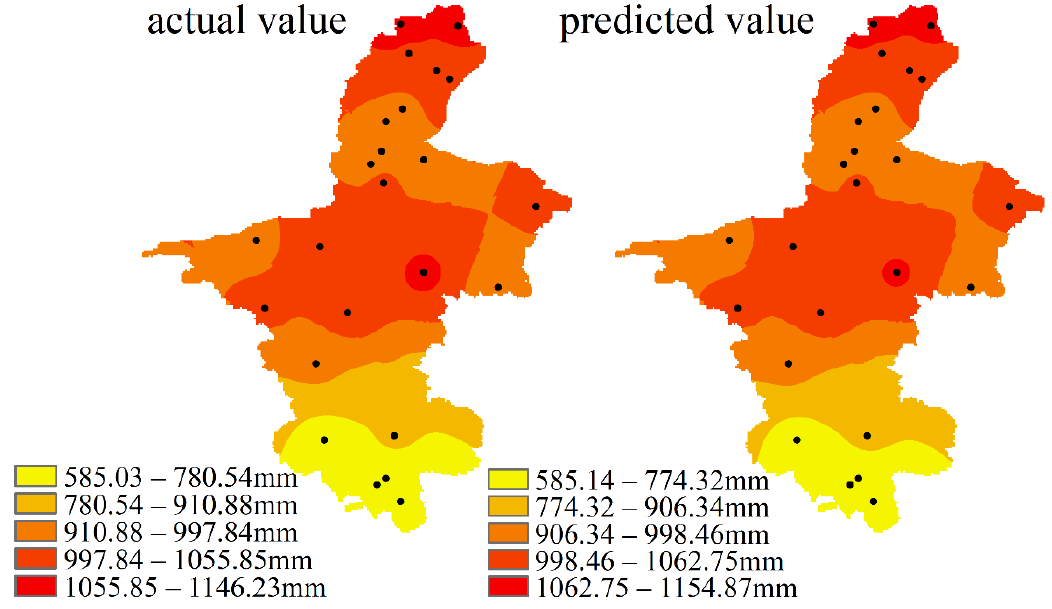
Figure 5. The annual average distribution of the actual and predicted values of the fitted back-alternative.